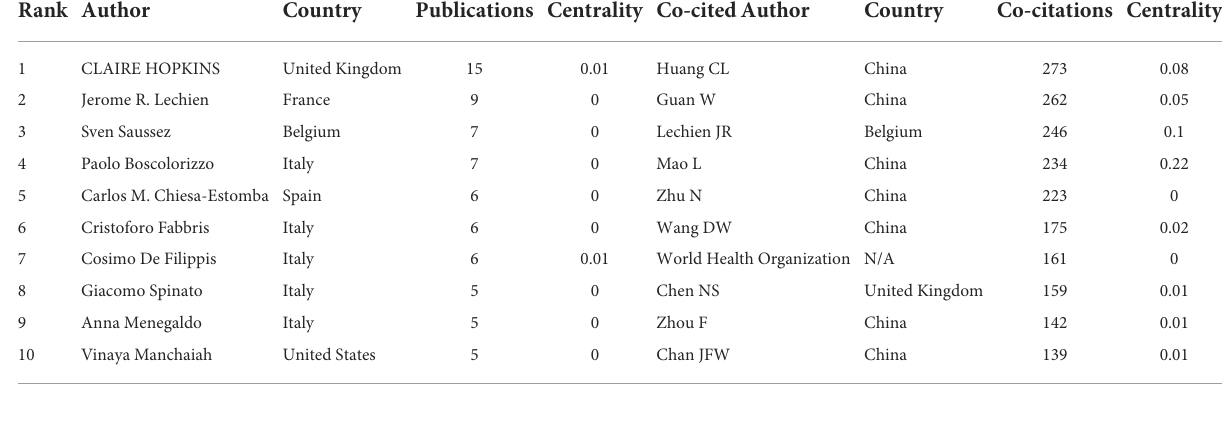
TABLE 3 Top 10 authors and co-cited authors involved in research.